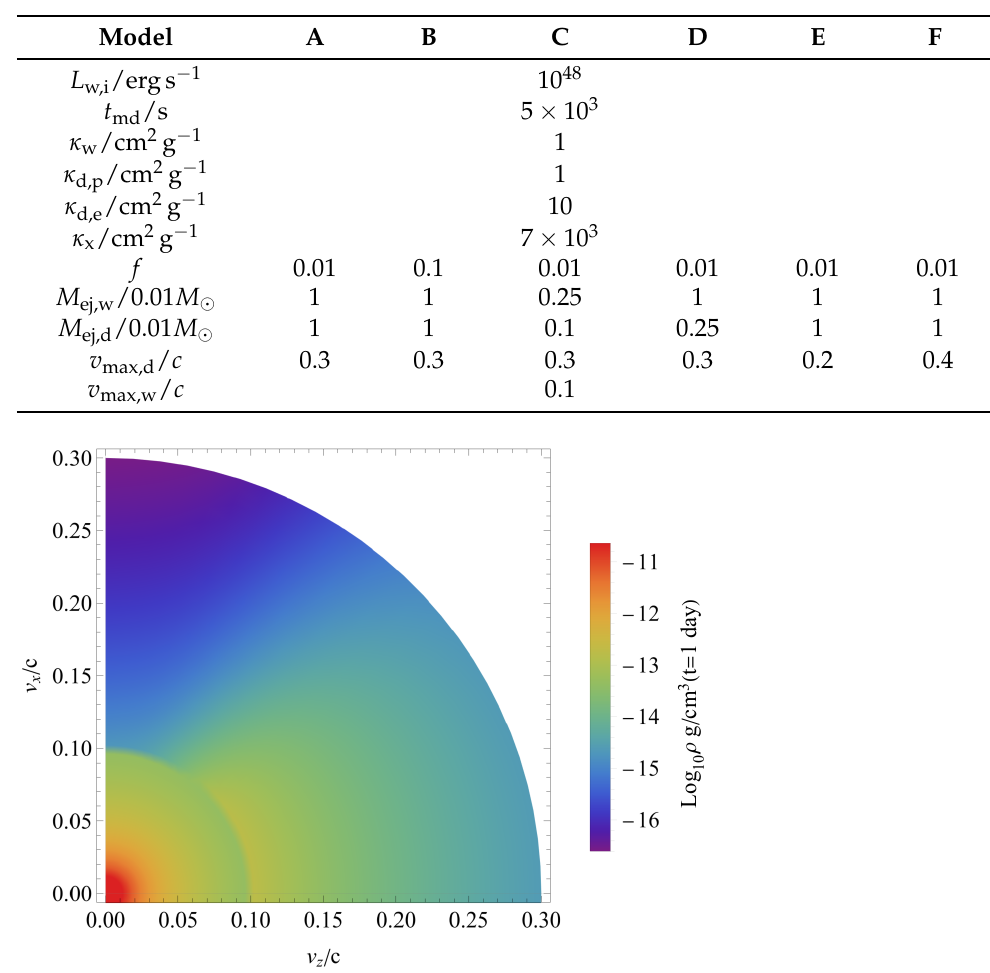
Table 1. Model parameters.